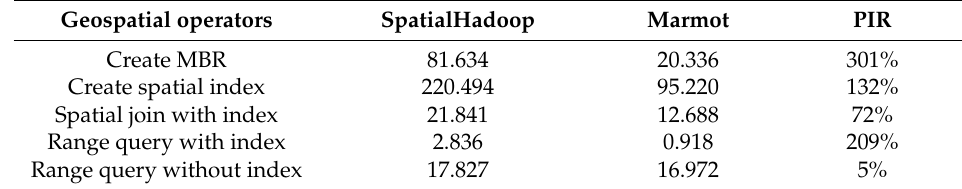
Table 4. A comparison of execution time and performance improvement rate (PIR) (in